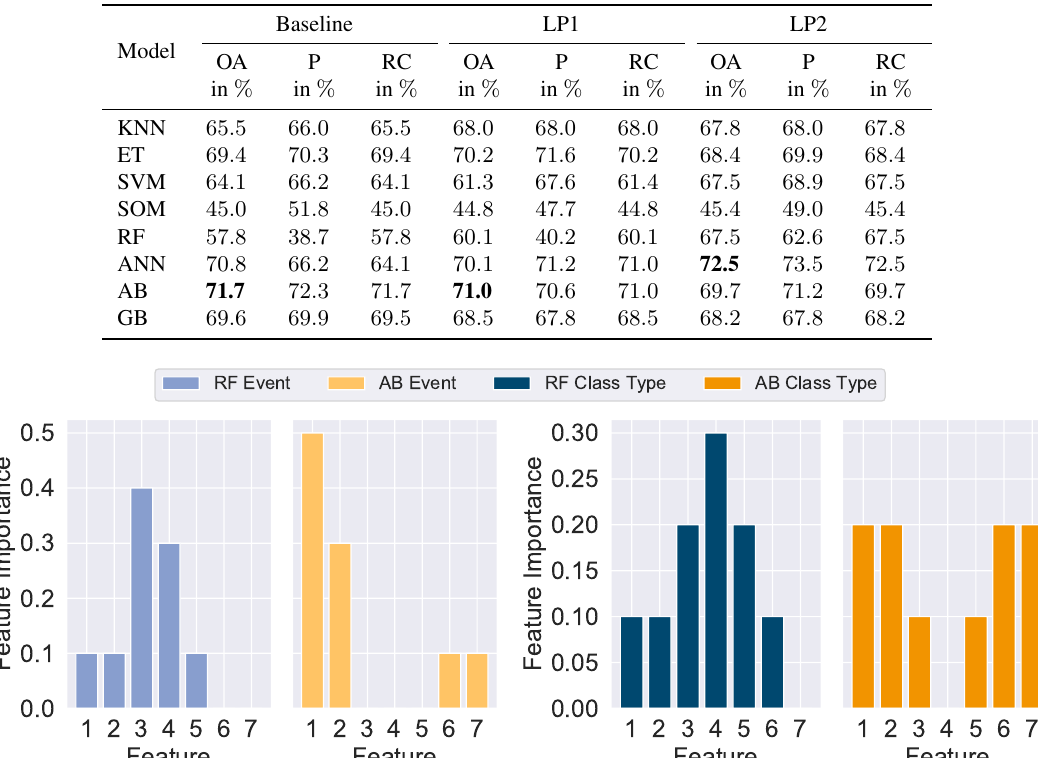
Figure 8. Feature importance of RF and AB with the LP1 approach for both classification tasks, event vs. no event and class type classification. The feature numbers correspond to Table